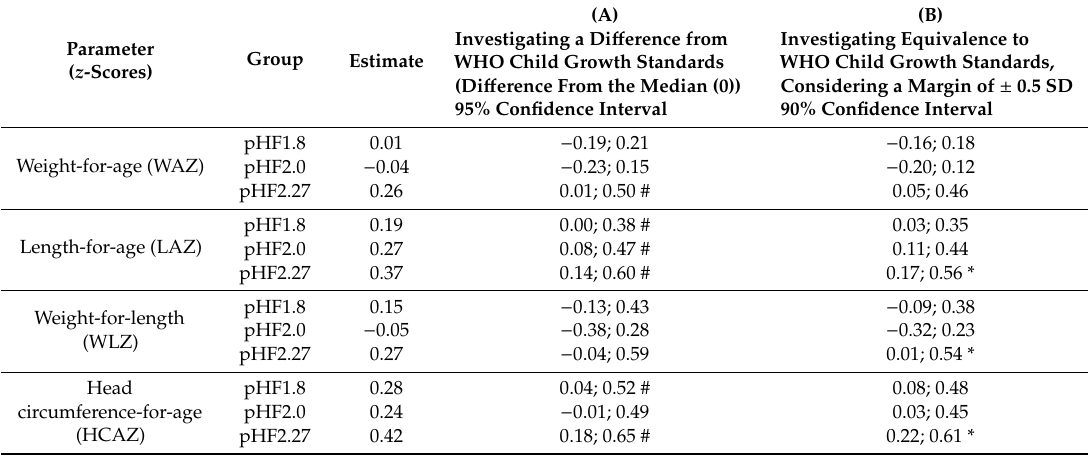
Table 3. Estimated z -scores of growth outcome parameters at 4 months age of the PP population, evaluating (A) di ff erences from WHO Child Growth Standards based on 95% CI or (B) equivalence to WHO Child Growth Standards based on 90% CI.